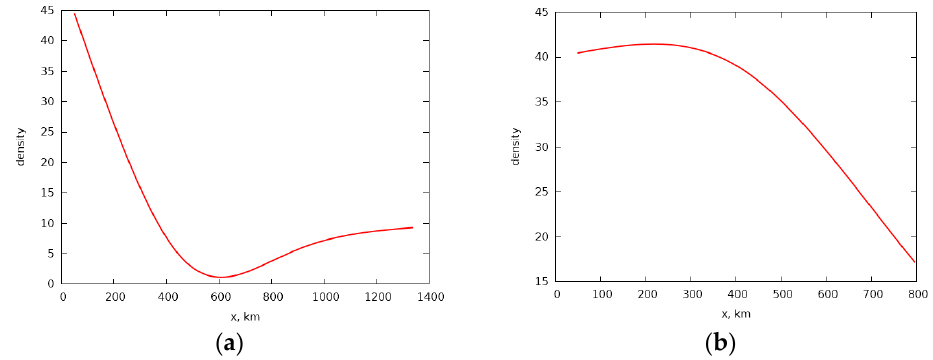
Figure 5. Linear density of population in Chile. ( a )—to the north of Santiago. ( b )—to the south of Santiago. The graphs were plotted through 4 points for North and 3 points for South excluding a data point for Santiago Metropolitan Region for clarity (population density in Santiago is approximately equal to 457 people per linear kilometer).